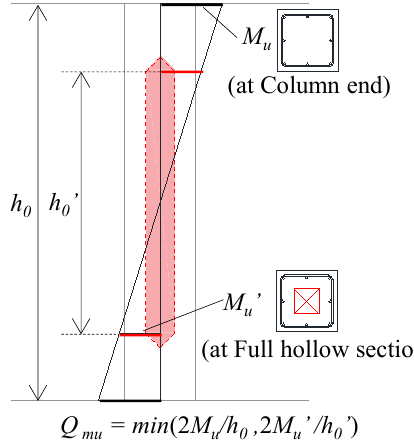
Figure 2. Calculation method of Q mu .